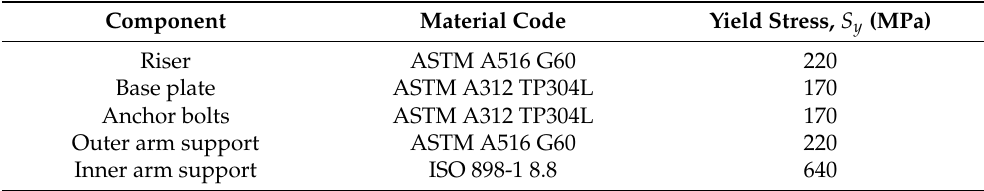
Table 7. Design value of yield stress.